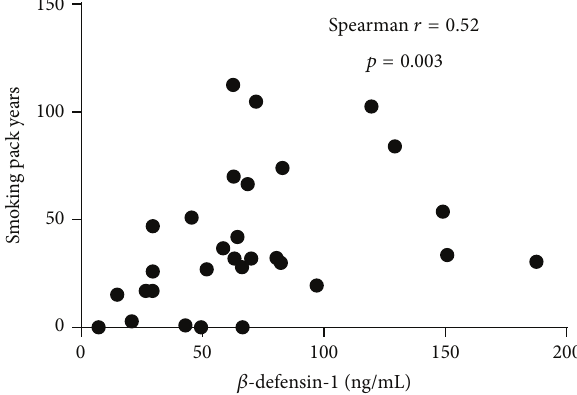
Figure 4: 𝛽 -defensin-1 and smoking history in COPD. The airway expression of 𝛽 -defensin-1 protein is correlated with pack years